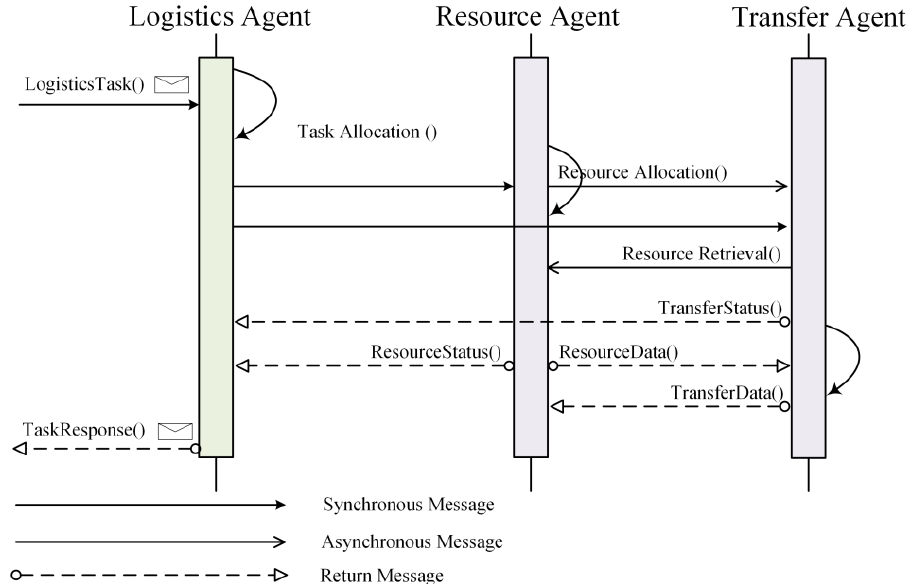
Figure 9. Collaboration protocol within logistics function domain.